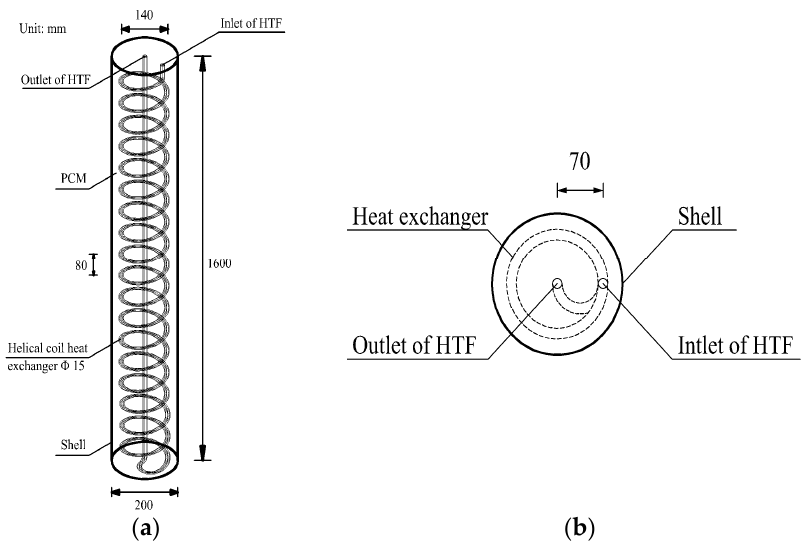
Figure 2. Schematic diagram of the cylindrical TES unit: ( a ) 3D geometry; ( b ) Cross section.